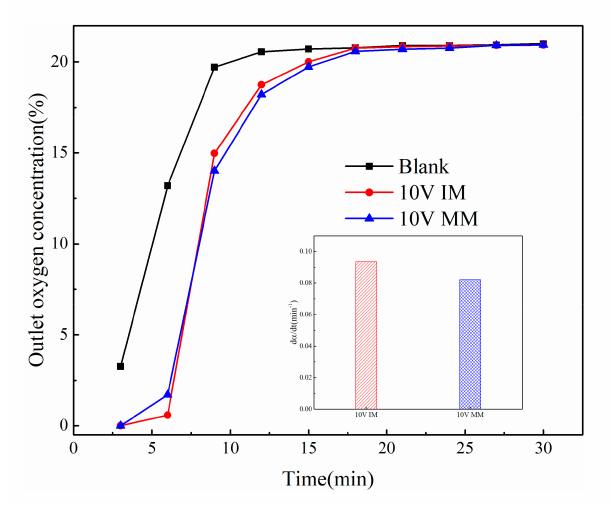
Figure 8. The oxidation performance for 10V IM and 10V MM at 435 ◦ C.